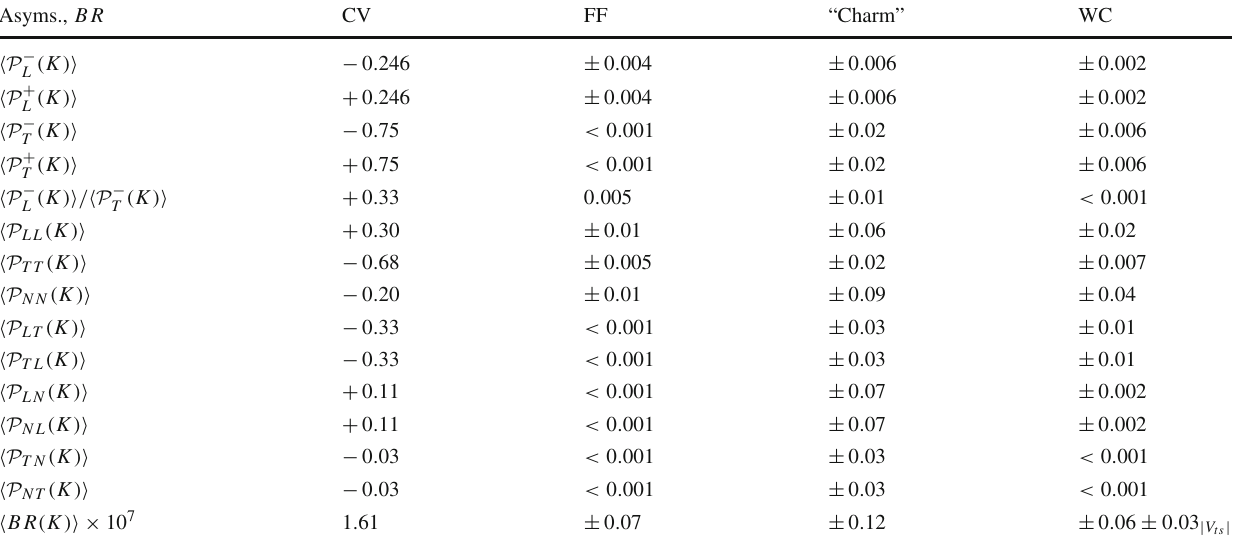
arbitrary CP -evenphasee i θ ,whichisallowedtovaryfreely.Finally,the column labeled “WC” corresponds to the effect of variating the Wilson coefficients given in Table 1 by 2 %, and include for the branching ratio the effect of the uncertainty on the value of | V ts | . The asymmetries A FB timesan and P ± vanish in this case. All uncertainty intervals are symmetrized N 9